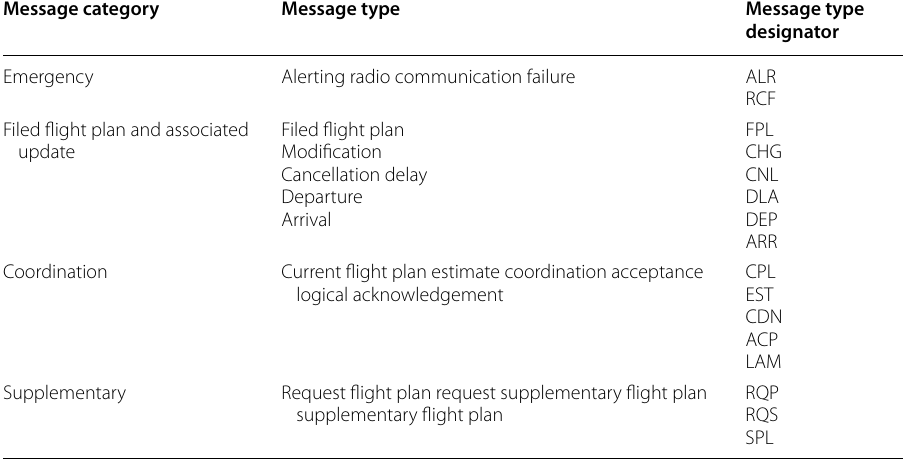
Table 1 Various types of flight safety